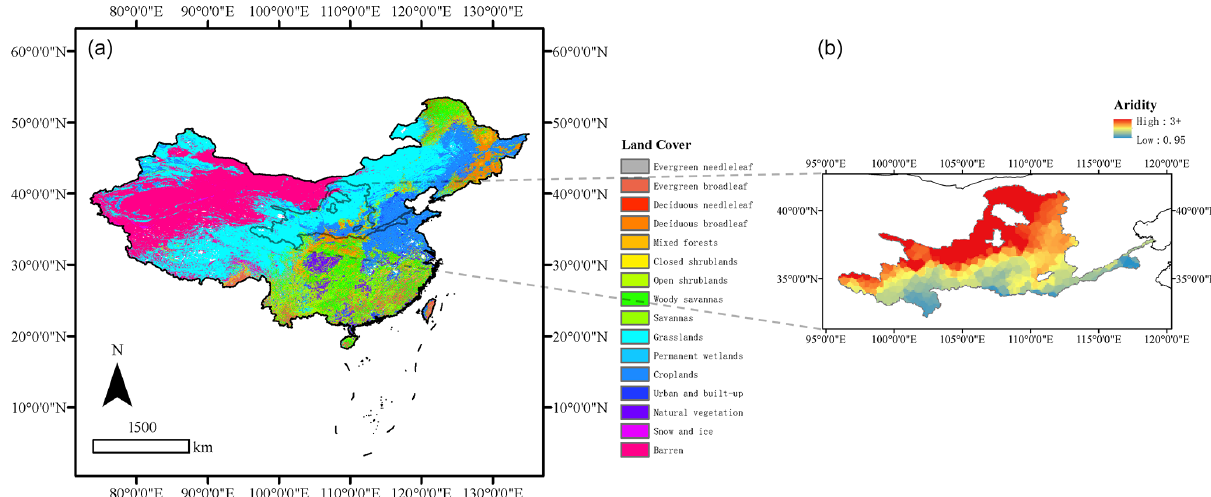
Figure 1. (a) Study area of CCAM and the distribution of land cover types. The studied basins cover the whole of China. (b) Study area of HydroMLYR and the distribution of aridity (PET/P) index. YRB is a generally arid area. The dataset provided can be used as a good sample for studying hydrology in arid regions. Table 1. Number of computed attributes in CAMELS, CAMELS-BR, and CCAM.